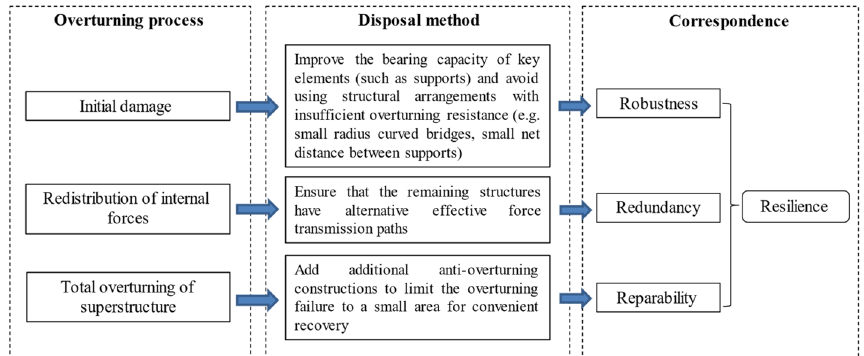
Fig. 23 Correspondence between structural anti-overturning and resilience design criteria